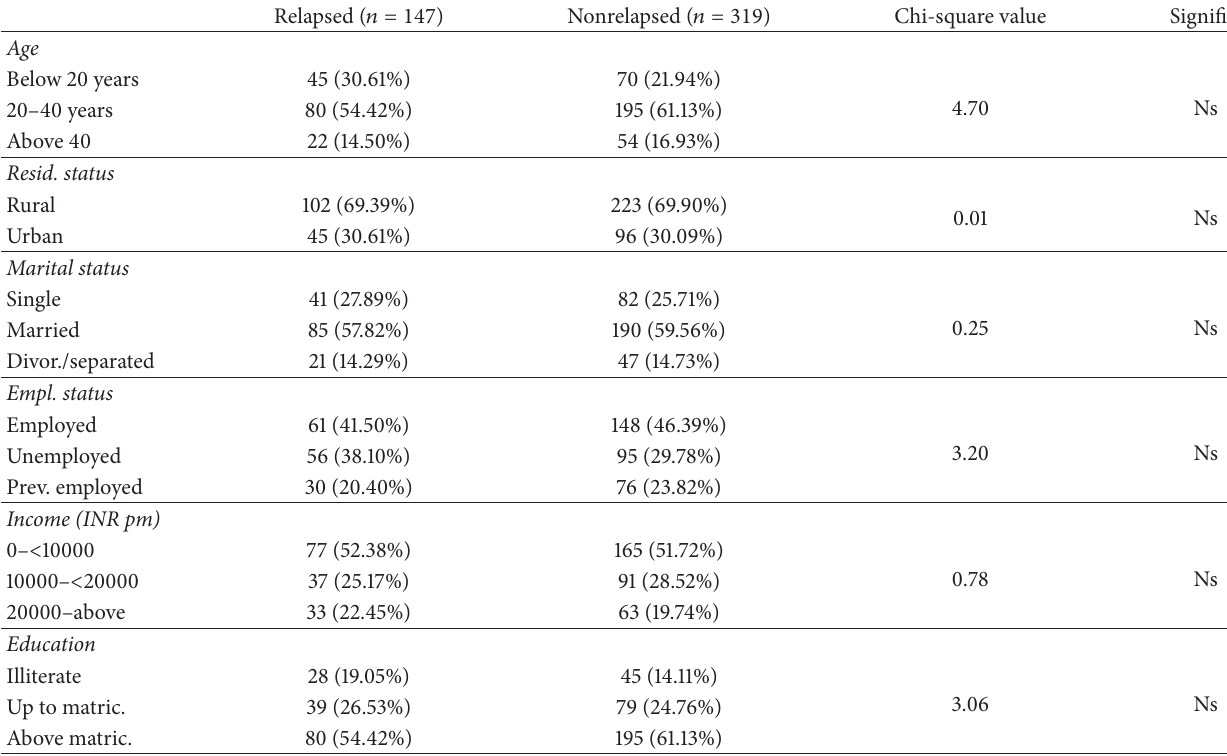
Table 1: Sociodemographic